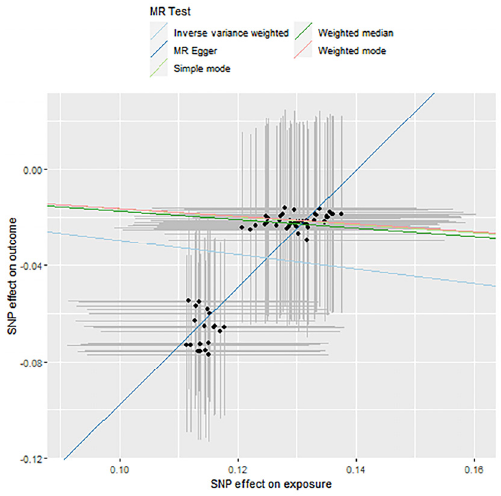
Figure 7. Causality analysis of Bifidobacteria and blood lipid levels based on Mendelian randomization. The x -axis represents the effect value associated with SNP and Bifidobacteria , and the y -axis represents the effect value associated with SNP and LDL and levels in the blood.